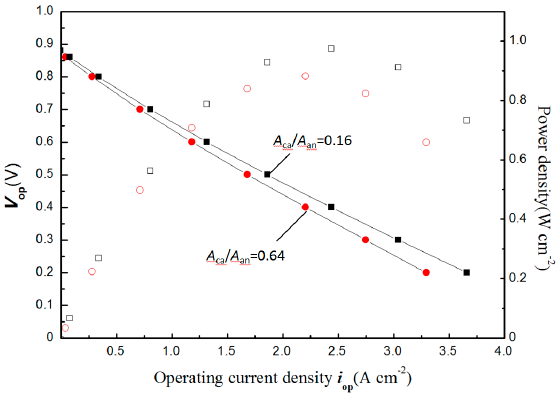
Figure 9. i op - V op performances between the buttons cells with different cathode/anode surface areas ratios (i.e., A an = 3.14 × 10 − 2 cm 2 , A ca / A an = 0.64 and 0.16).